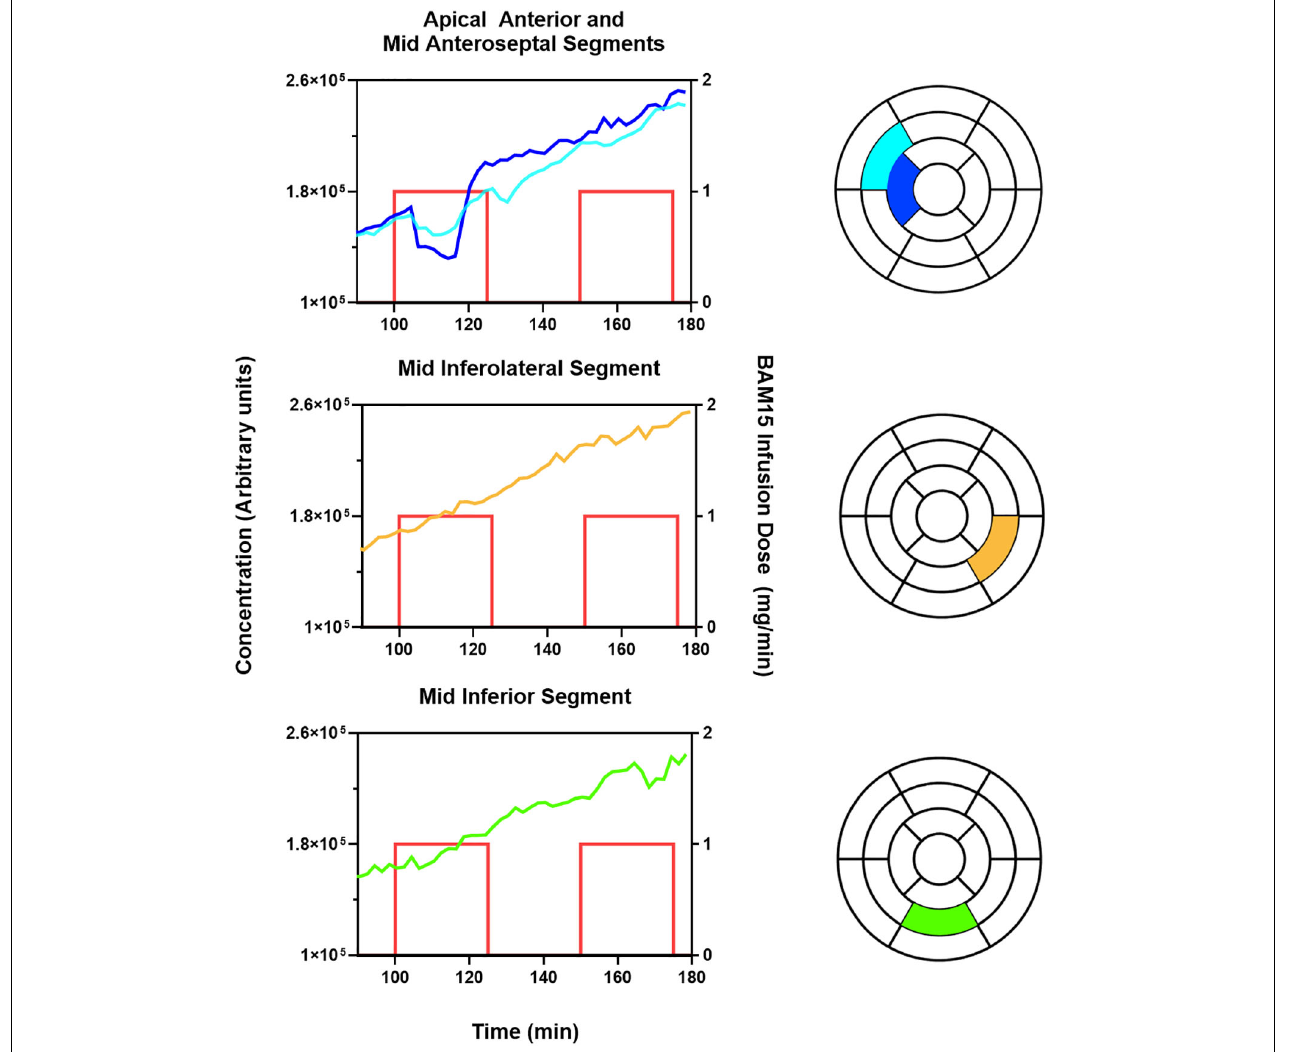
FIGURE 2 | BAM15 infusion in left anterior descending (LAD) artery causes depolarization of myocardium in corresponding vascular territory, with less effect in left circumflex (LCx), and right coronary artery (RCA). The blue and aqua colored lines index the 18 F-TPP + concentration versus time for specific cardiac segments corresponding to the LAD territory as indicated by the text above each graph. The yellow and green colored lines index the 18 F-TPP + concentration versus time for specific cardiac segments corresponding to the LCx and RCA territory, respectively. The standard 17 segment polar map of the myocardium is also provided for each graph, to help the reader visualize the location of the plotted segments. The red lines denote the times during which BAM15 was infused; the height of the lines indicate the infusion dose